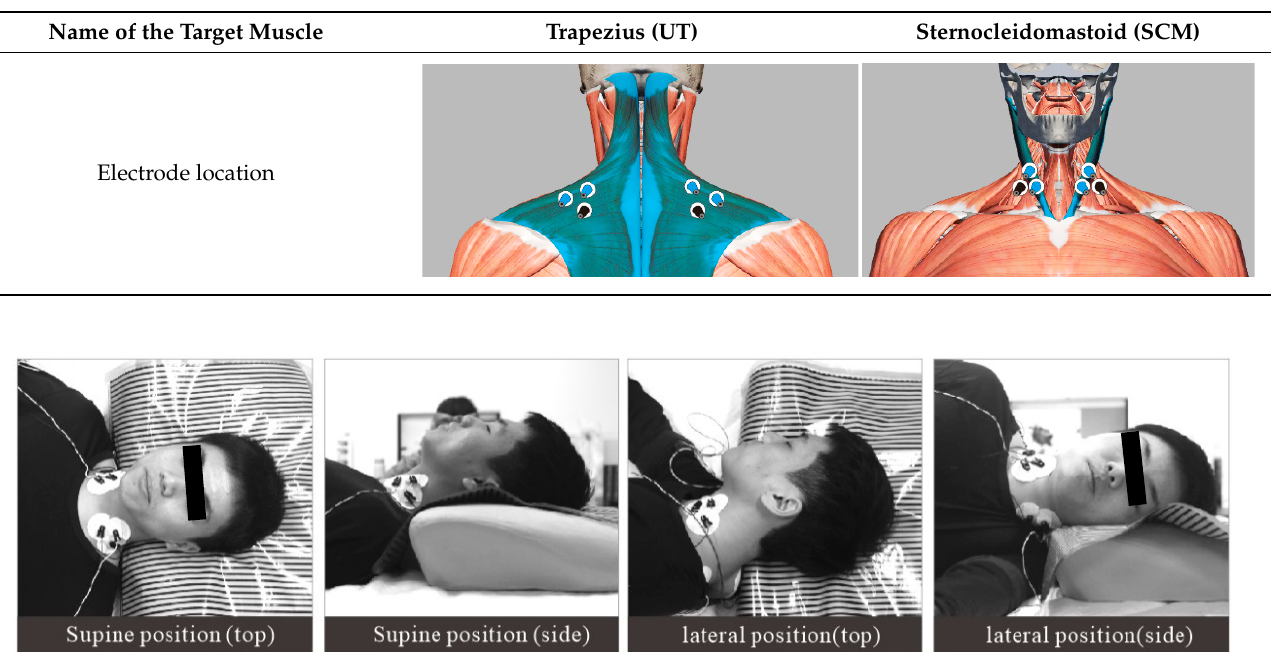
Table 2. Instructions for the location of the muscle to be tested and the electrode sheet to be pasted.